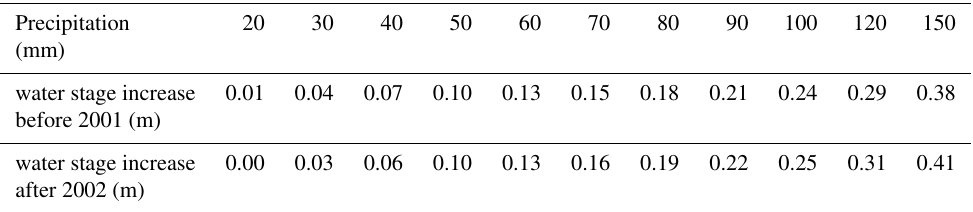
Table 8. Average annual inflow and outflow of Taihu Lake variation before 2001 and after 2002. ZX HX Wangting Taipu YCDM HJH WCXY Total Sluice Sluice Inflow − 0 . 23 2.36 0.83 − 0 . 01 0.14 − 0 . 73 − 0 . 30 2.06 ( × 10 9 m 3 ) Outflow 0.48 − 0 . 13 0.12 − 0 . 31 − 0 . 21 0.41 − 0 . 11 0.25 ( × 10 9 m 3 ) Net flow − 0 . 71 2.49 0.71 − 0 . 35 1.14 0.19 1.81 ( × 10 9 m 3 ) Negative value means decreasing and positive value means increasing. Table 9. Relationships between precipitation and water stage increase before 2001 and after 2002. Precipitation 20 30 40 50 100 150 (mm) water stage increase 0.01 before 2001 (m) water stage increase 0.00 0.03 after 2002